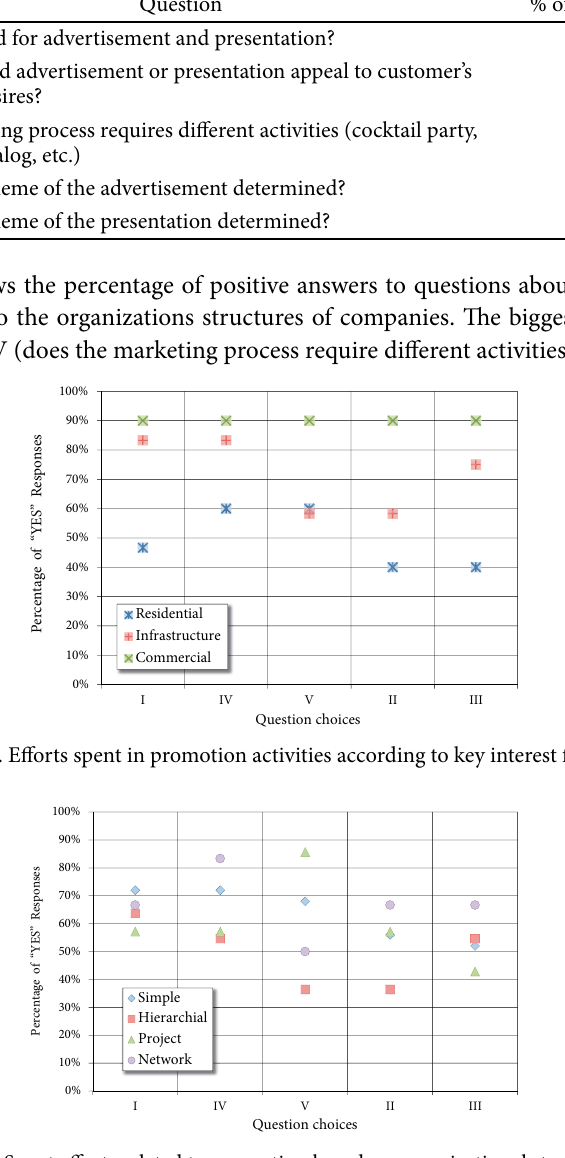
Fig. 14. Spent efforts related to promotion based on organizational structure